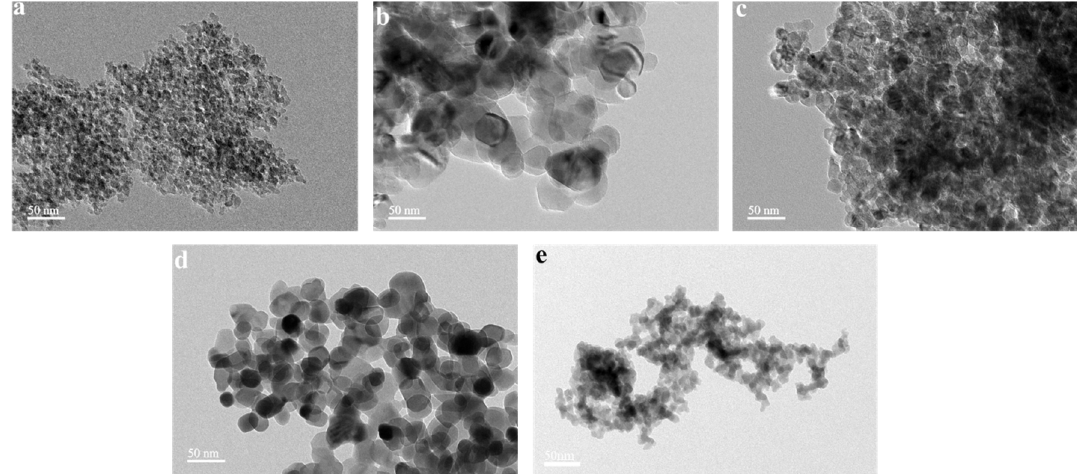
Figure 3. TEM images of ( a ) γ -Al 2 O 3 ; ( b ) MgO; ( c ) TiO 2 ; ( d ) ZrO 2 ; ( e ) SiO 2.